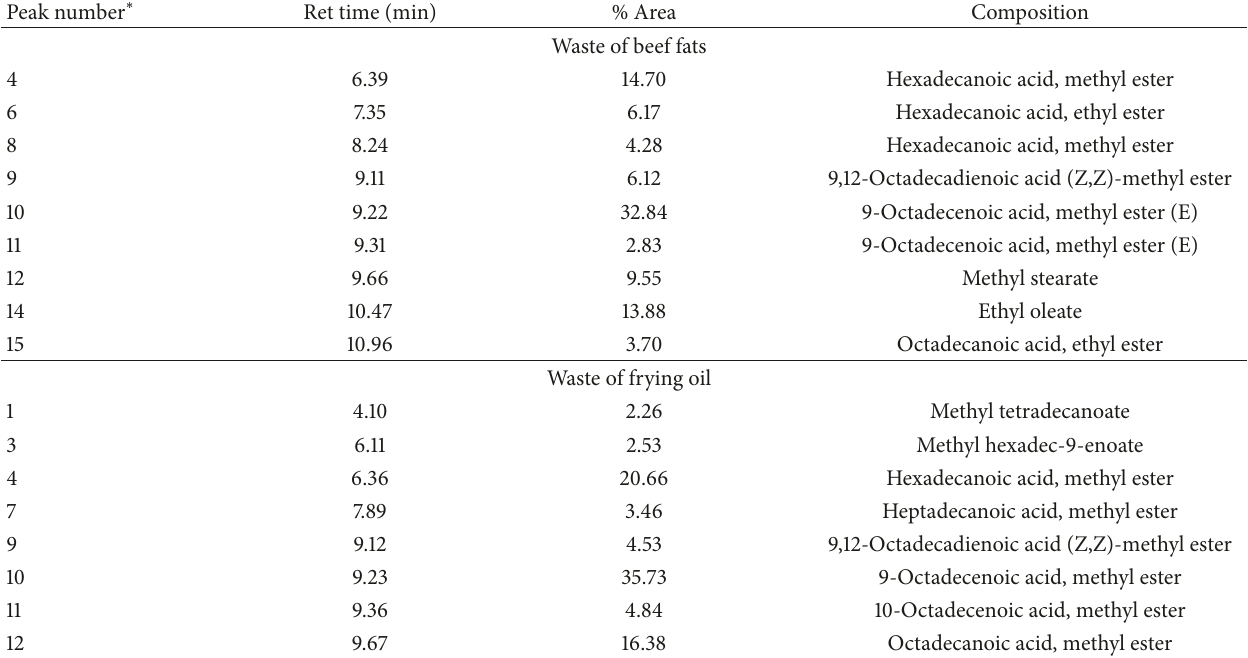
Table 3: Quantitative composition of the FAMEs of biodiesel formed by whole-cell transesterification process. Peak number